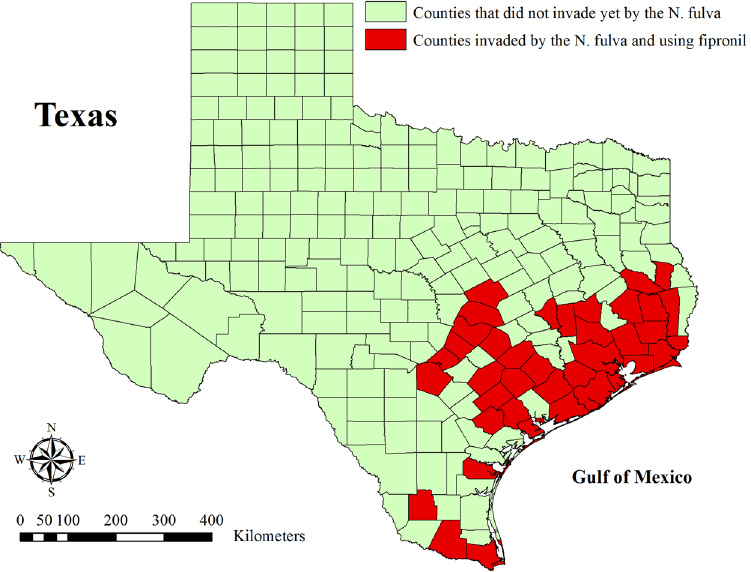
Figure 1. Map of Texas counties. Red color indicate the counties that have been invaded by the tawny crazy ants N . fulva and that are using fipronil based on the exemption issued by the U.S. EPA in 2016 to control the